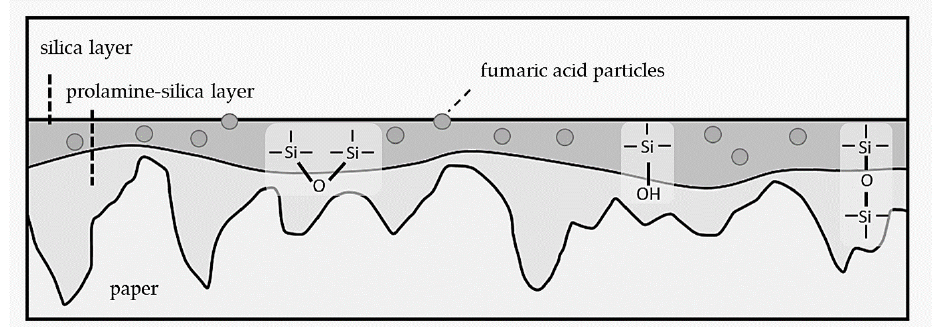
Figure 1. The profile scheme of the applied multilayer on the paper substrate.